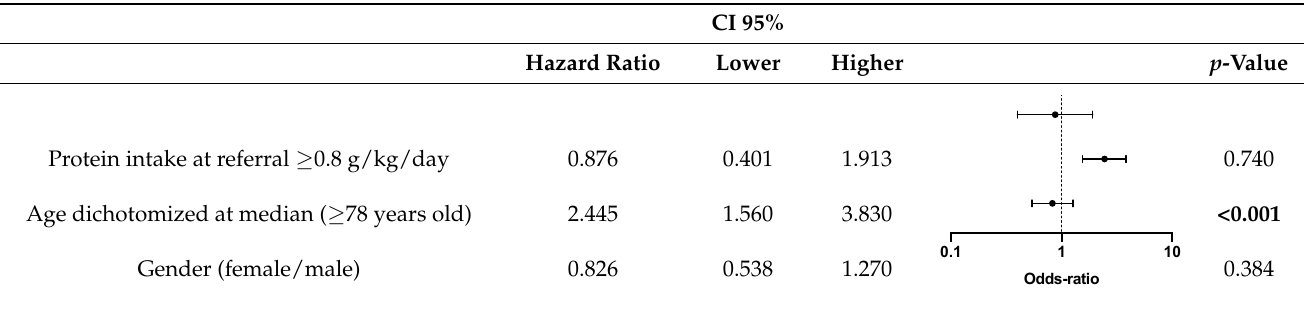
Table 5. Cox regression analysis of survival according to baseline diet and age.